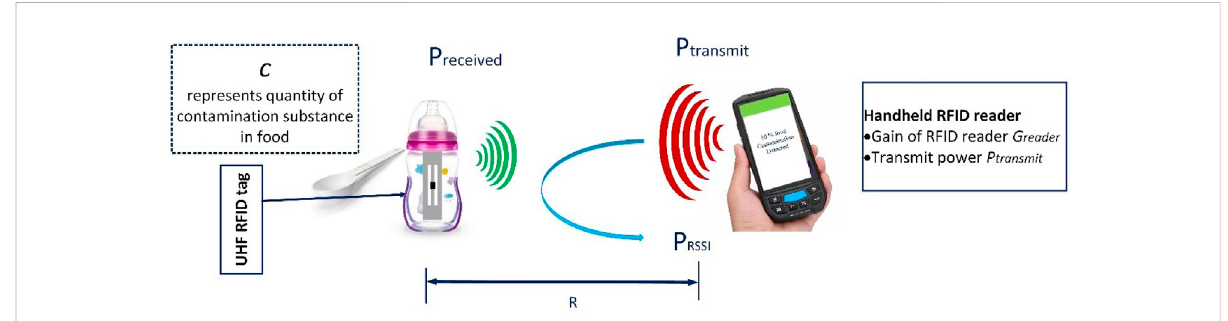
Frontiers in Communications and